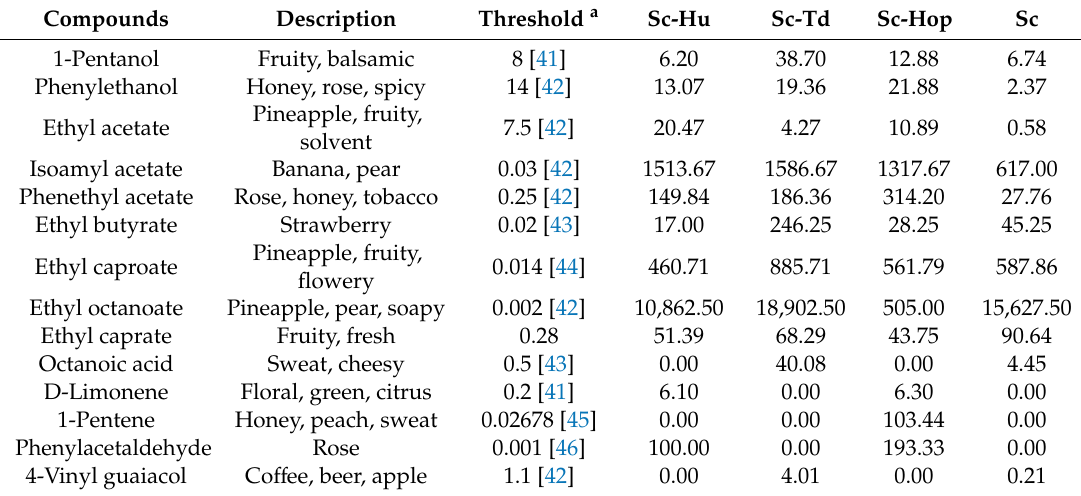
Table 3. Volatile odor-active compounds (OAV ≥ 1) in citrus